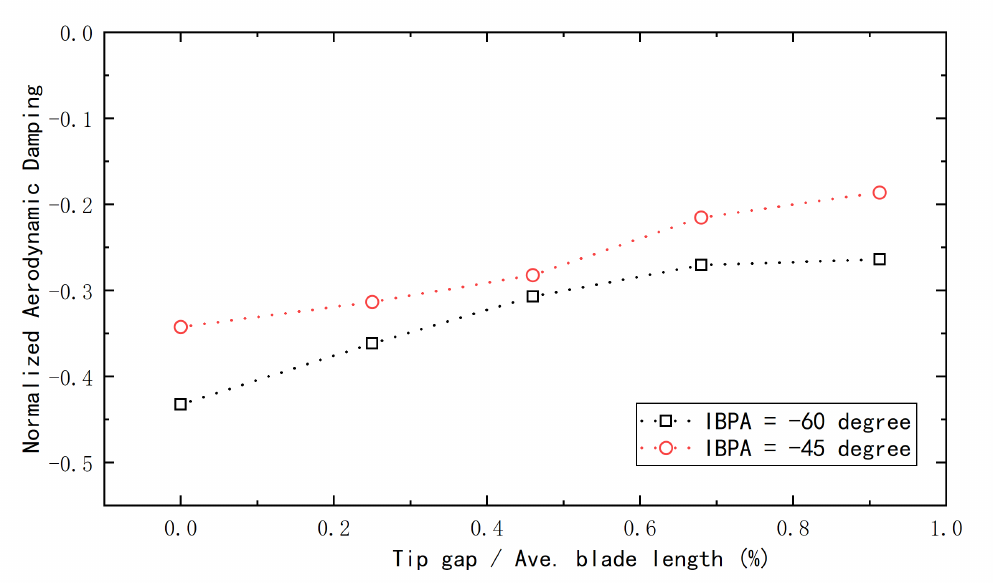
Figure 8. Aerodynamic damping versus tip gap height at the two unstable IBPAs.